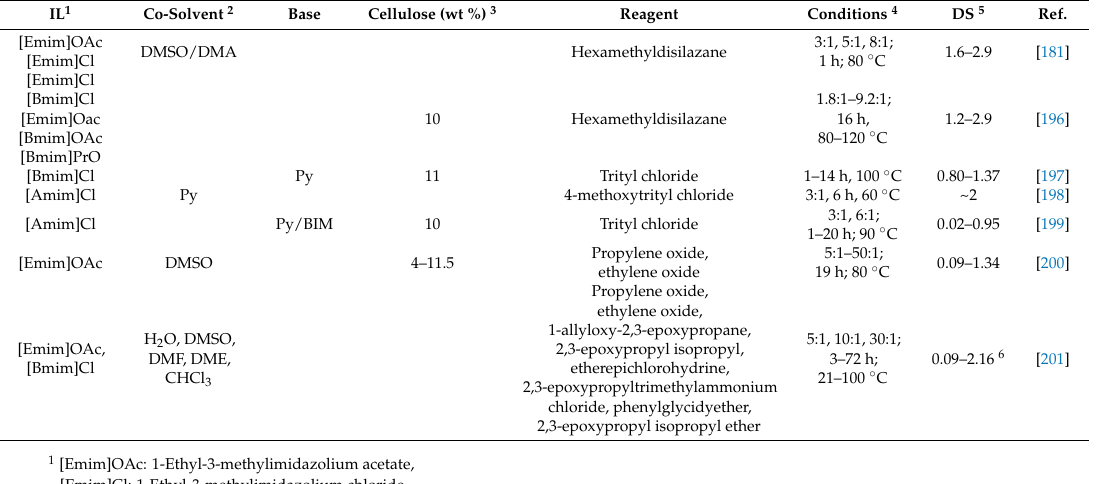
Table 5. Conditions of reaction media for the homogeneous etherification of cellulose and DS of the cellulose